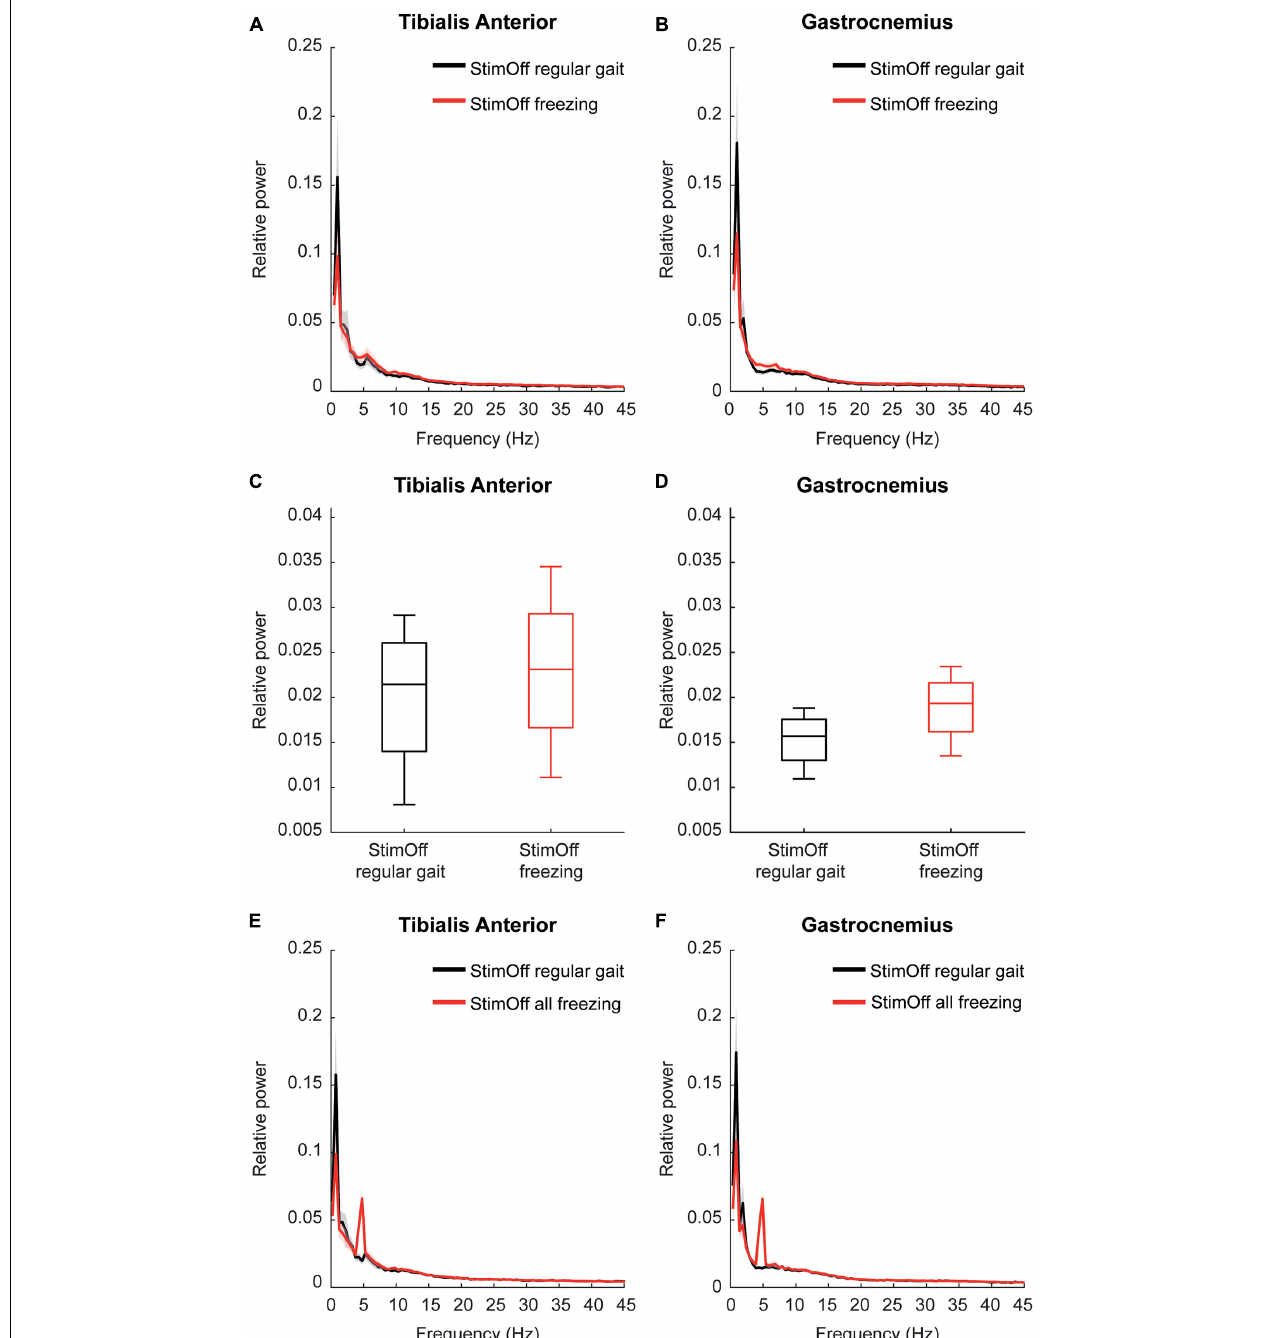
FIGURE 2 | (A,B) Power spectrum and SEM of TA (upper left panel) and GA (upper right panel) in 4 PD patients with ‘StimOff’ comparing ‘regular gait’ and ‘freezing.’ Freezing episodes showed higher median power in TA and GA between 5 and 10 Hz, however, this difference did not show significance and has to be considered with caution owing to the limited number of patients showing freezing episodes during straight walking. (C,D) Alpha/low-beta power observed in ‘StimOff‘ during regular gait and freezing episodes in TA (middle left panel) and GA (middle right panel). There was no significant difference between the two conditions. Data is presented in boxplots giving the median, 25, 75th percentile, min and max. (E,F) Power spectrum and SEM of TA (lower left panel) and GA (lower right panel) in 5 PD patients with ‘StimOff’ comparing ‘regular gait’ and ‘ all freezing’ episodes. Freezing episodes showed higher median power in TA and GA between 5 and 10 Hz, however, this difference did not show significance and has to be considered with caution owing to the limited number of patients showing freezing episodes. Please note the prominent peak at 5 Hz in TA and GA. Visual inspection of the video recordings as well as of the EMG raw data did not reveal tremor-associated activation. Further, the individual frequency spectra of the 5 subjects did not show similar peak activation but a broader low-frequency activation band known from freezing episodes (Moore et al., 2008; Vercruysse et al., 2012) as opposed to tremor that occurs in a stable circumscribed frequency bin in the individual subject.